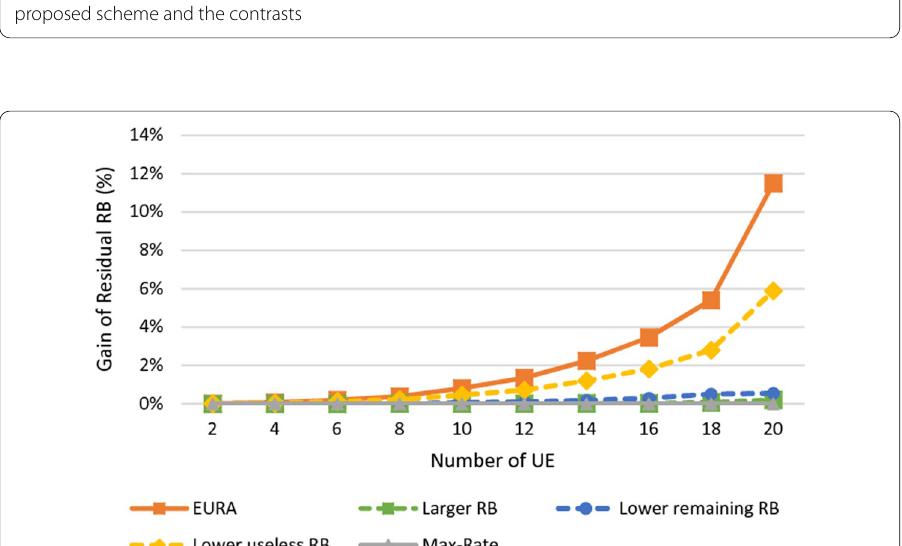
Fig. 15 Gain of residual RBs between EURA with three mechanisms and Max Rate; The performance gain of residual RBs between EURA with three mechanisms and Max